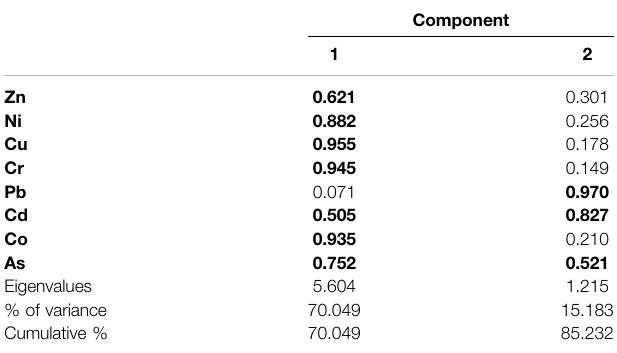
TABLE 8 | Varimax rotated component matrix for selected trace elements in the studied sediments.